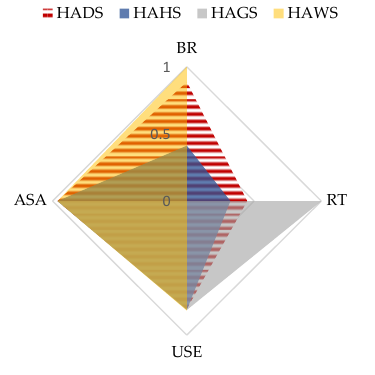
Figure 23. The radar chart of data set 5 when N a =